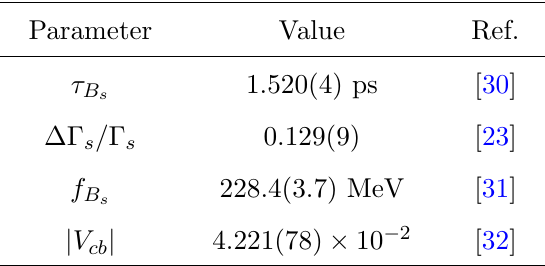
+ (cid:22) (cid:0) ) using flavio v0.20.4. s ! (cid:22)